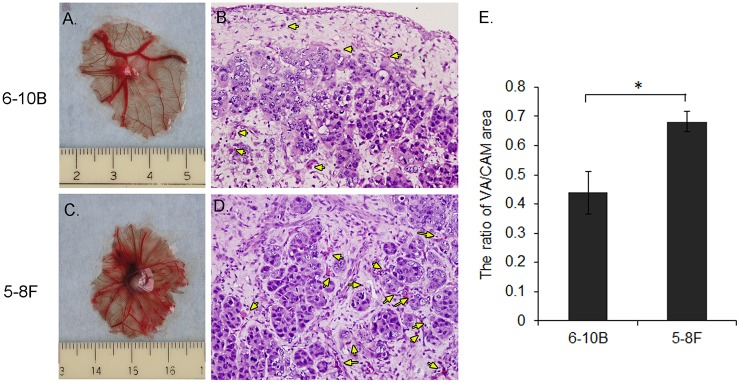
Neovascularization in CAMs after inoculation with 5-8F and 6-10B cells.A and C: Macro images of xenografts and blood vessels. B and D: H&E staining. Blood vessels with nucleated erythrocytes are indicated with yellow arrows. E. Quantification of neovascularization ratio calculated by dividing the area of blood vascularization (VA) to total area of CAM. Data are mean ± SD (n = 3). * P<0.01.